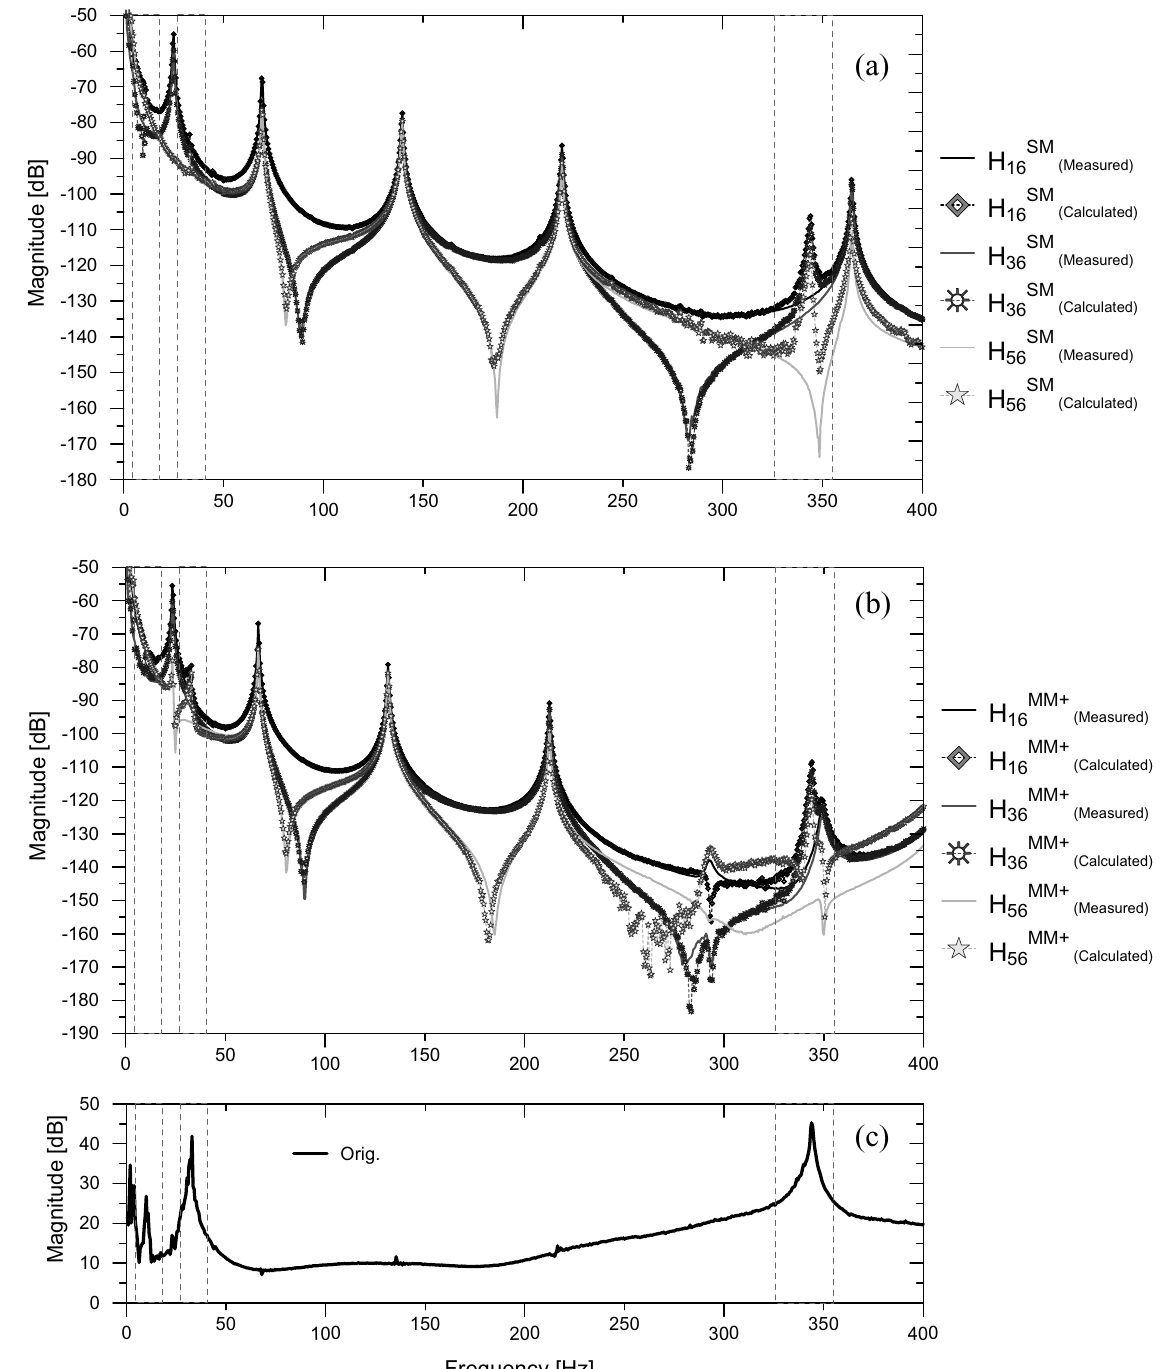
Fig. 8. (a) Measured and estimated Receptances H (cid:2) 14 ,H (cid:2) 36 and H (cid:2) 56 for the (b) stiffness modified structure (SM) and (c) mass modified structure (MM+), (c) Transmissibility Indicator for the original